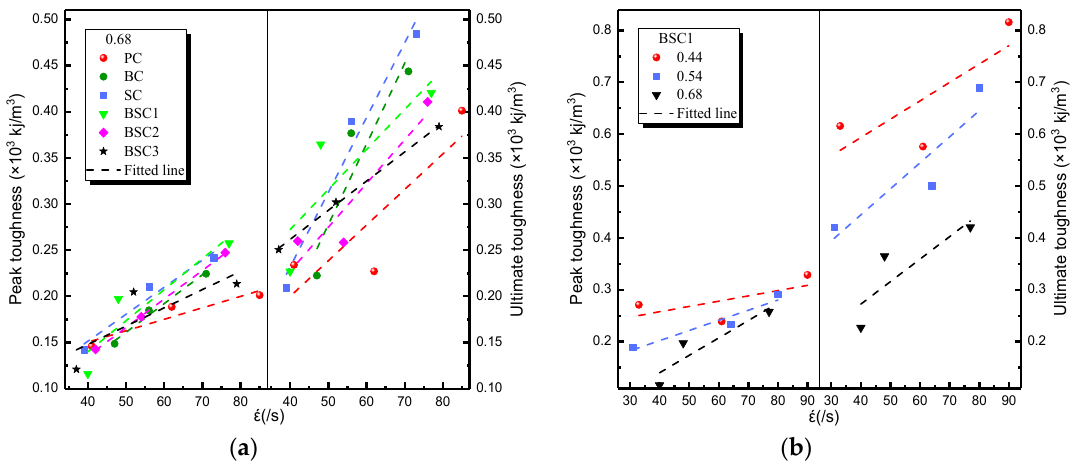
Figure 15. Strain rate effect on impact toughness of BSFRC: ( a ) w/c ratio: 0.68; ( b ) BSC1.